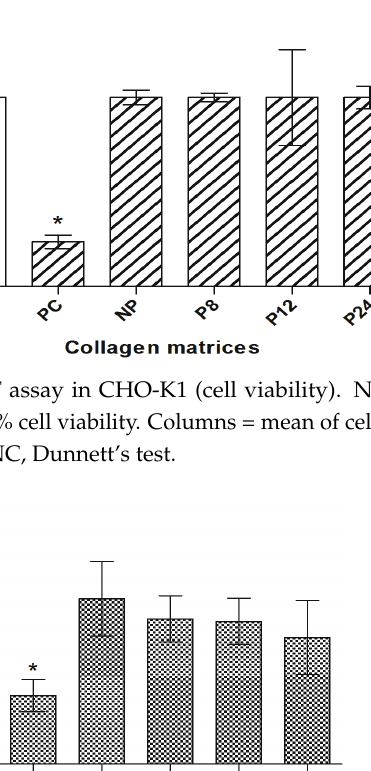
Figure 4. Comet assay in CHO-K1. NC: negative control; PC: positive control. Columns = mean of percentage of DNA in tail; bars = standard error. * = p < 0.01 compared to NC, Dunnett’s test. The analysis of variance (ANOVA) showed a statistically significant difference be- tween the PC and the NC as well as in relation to all the treatments of the matrices steri- lized with ethylene oxide. NP, P12, P24 and PC showed a statistically significant difference when compared to the NC ( p < 0.01, Dunnett’s), indicating a genotoxic response. Only the treatment with the P8 group showed no significant difference when compared to the NC. For the group of the matrices sterilized by gamma radiation, only PC and P8 pre- sented a statistically significant difference compared to NC ( p < 0.05, Dunnett’s); possibly, there was no difference due to the shorter time used for sterilization. The micronucleus test is a widely used test for the evaluation of the mutagenic po- tential. The frequency of micronuclei (MNi) and nucleoplasmic bridges (NPBi) in binucle- ate cells were evaluated, which demonstrate additional chromosomal damage infor- mation for sterilized matrices by ethylene oxide and gamma ray radiation (Table 2).